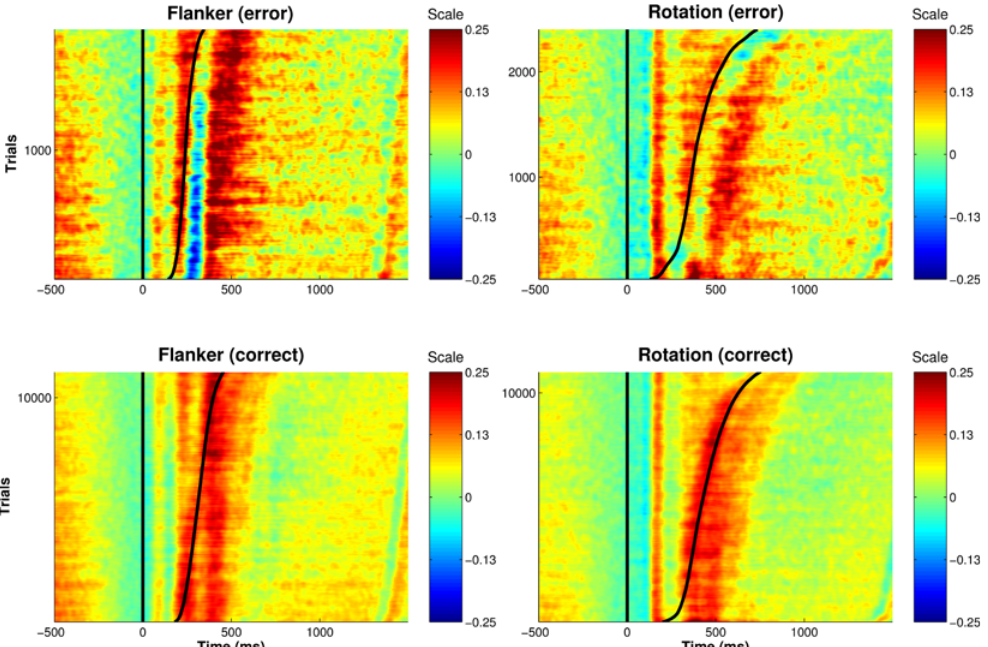
Fig 2. ERP images of the single-trial activity at FCz for trials of all subjects, tasks and accuracy conditions. Note that the single-trial data was normalized and scaled to a range of [-1,1] for each subject prior to concatenating all single-trials. Further, a moving average window (MA) of MA = 40 was applied across trials. The vertical line indicates stimulus onset; the sinusoid line indicates the response. All data were sorted by response time.